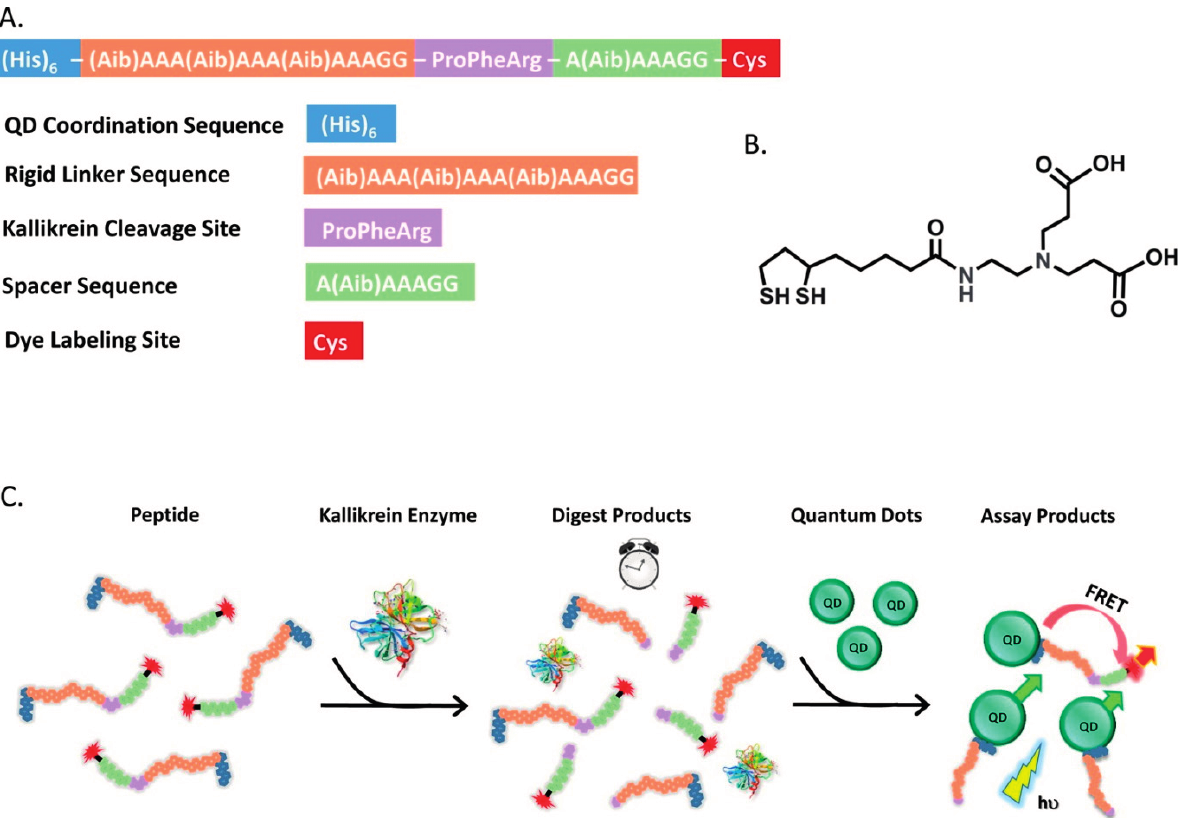
Figure 4. ( A ) Peptide sequence and sensor functional elements; ( B ) Chemical structure of the ligands on the QD surface; ( C ) Schematic illustration of the two-step assay for kallikrein proteolytic activity (Reprinted with permission from [77], Copyright 2014